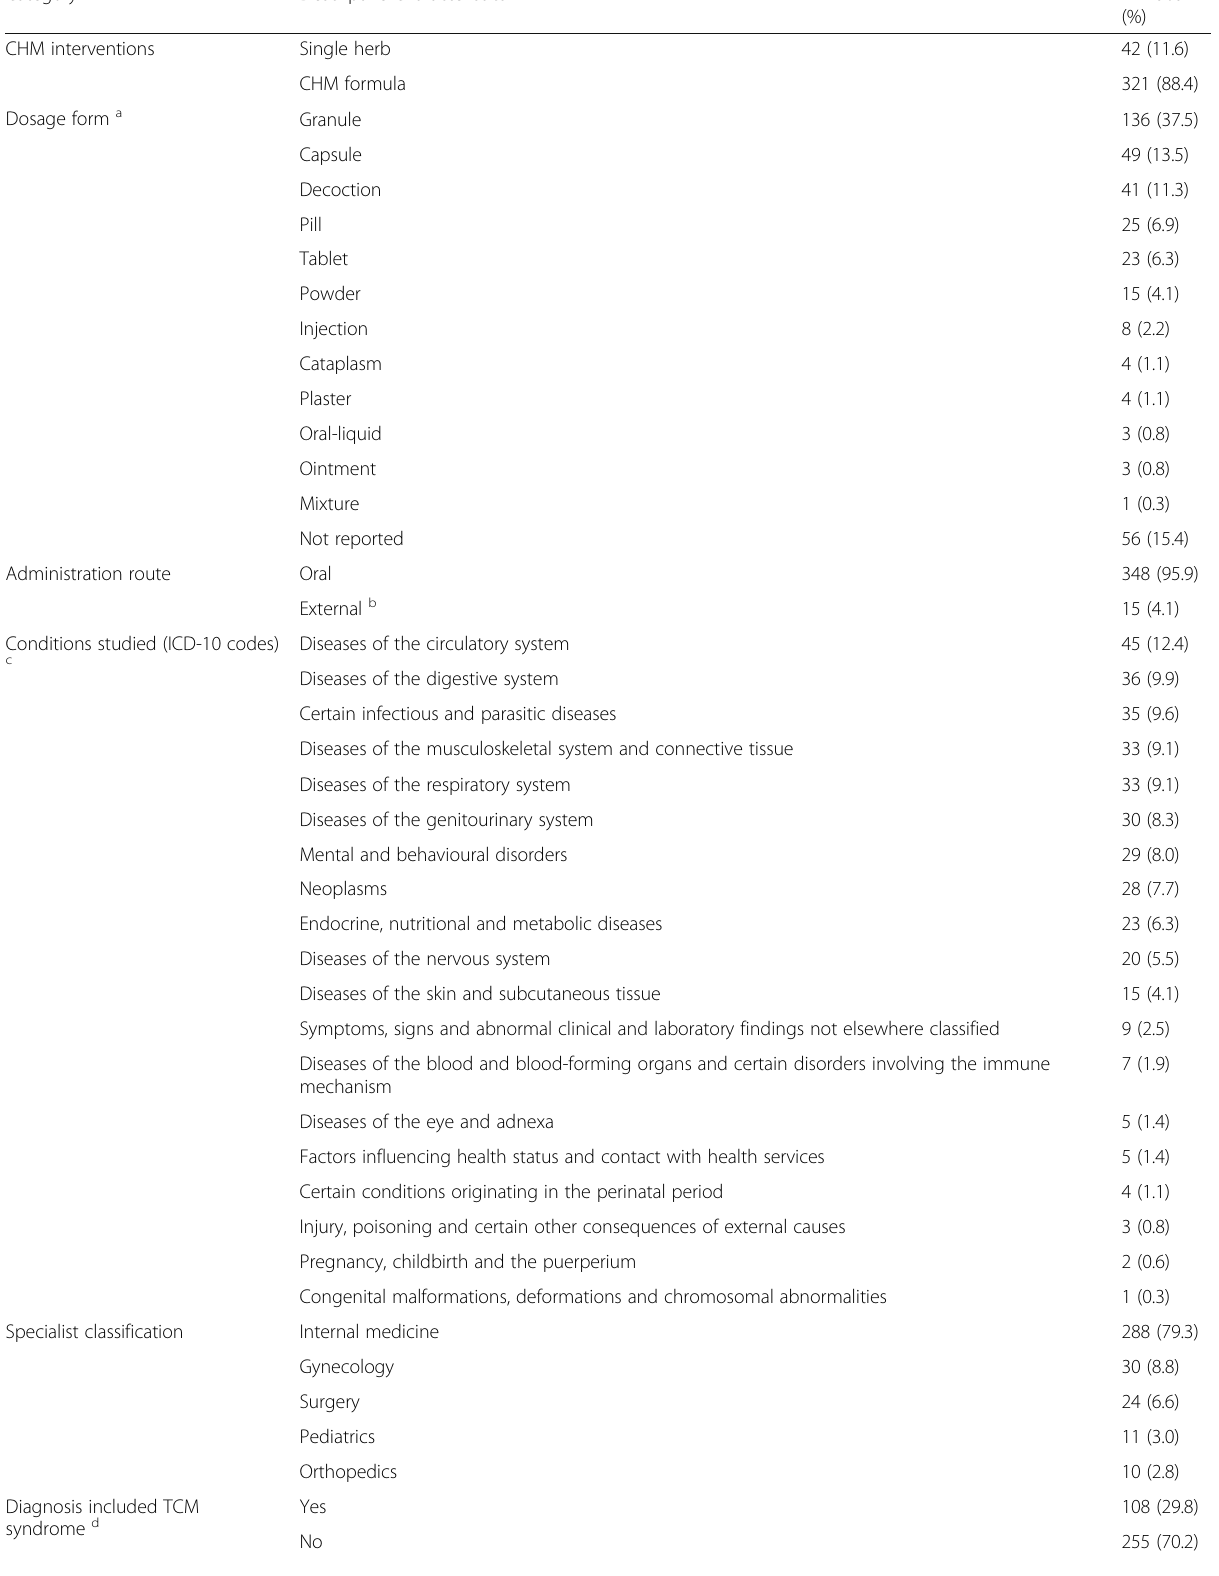
Table 1 Characteristics of the included